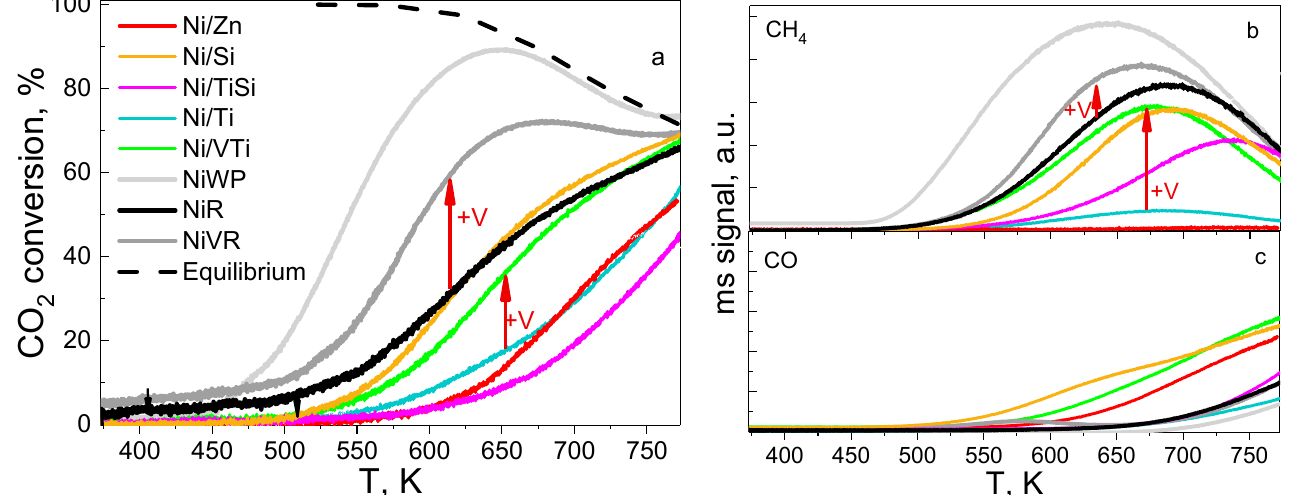
Figure 5. CO 2 conversion ( a ), CH 4 selectivity ( b ), and CO selectivity ( c ), as a function of temperature and for Ni-supported catalyst (NiWP and reference NiR, NiVR) performance given for comparison). Reaction condition GHSV = 1.2 × 104 h − 1 , 1 atm and 293 K) CO 2 /H 2 in the molar ratio 1/5.